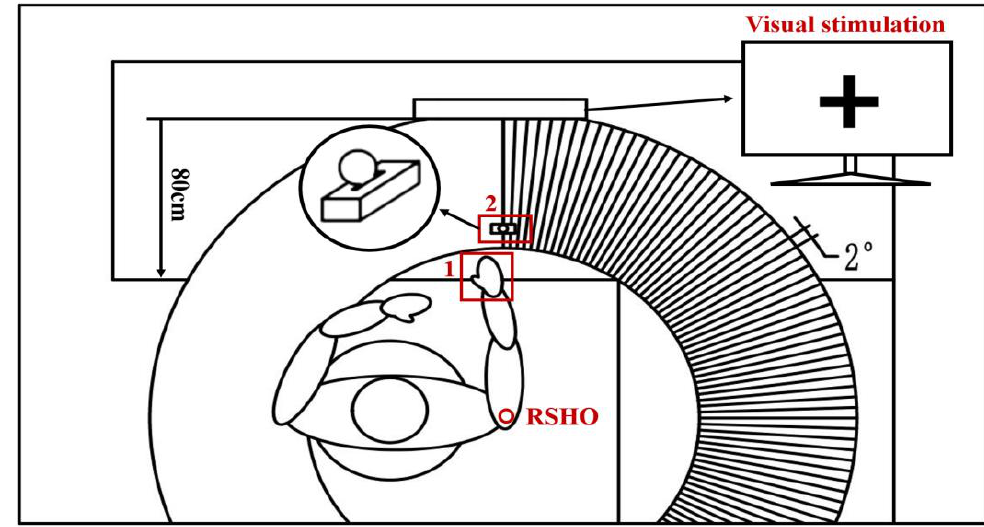
Figure 1. Table layout of the experiment, indicating the hand and object’s initial position. Part B Non-Gaze